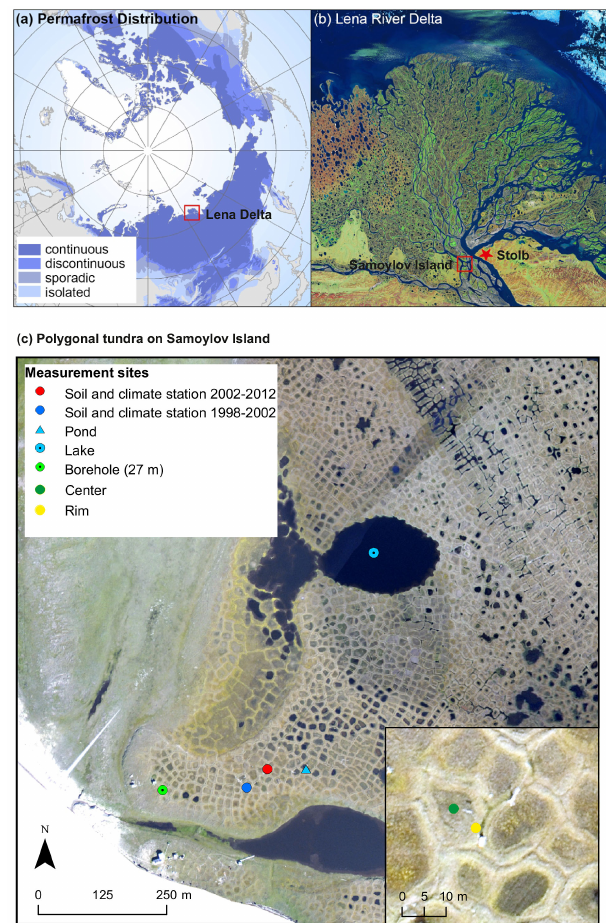
Figure 1. (a) Circumpolar permafrost distribution (Brown et al., 1998) and the Lena River delta. (b) Location of the Samoylov study site within the Lena River delta, eastern Siberia (NASA, 2000), and (c) measurement locations on Samoylov Island.